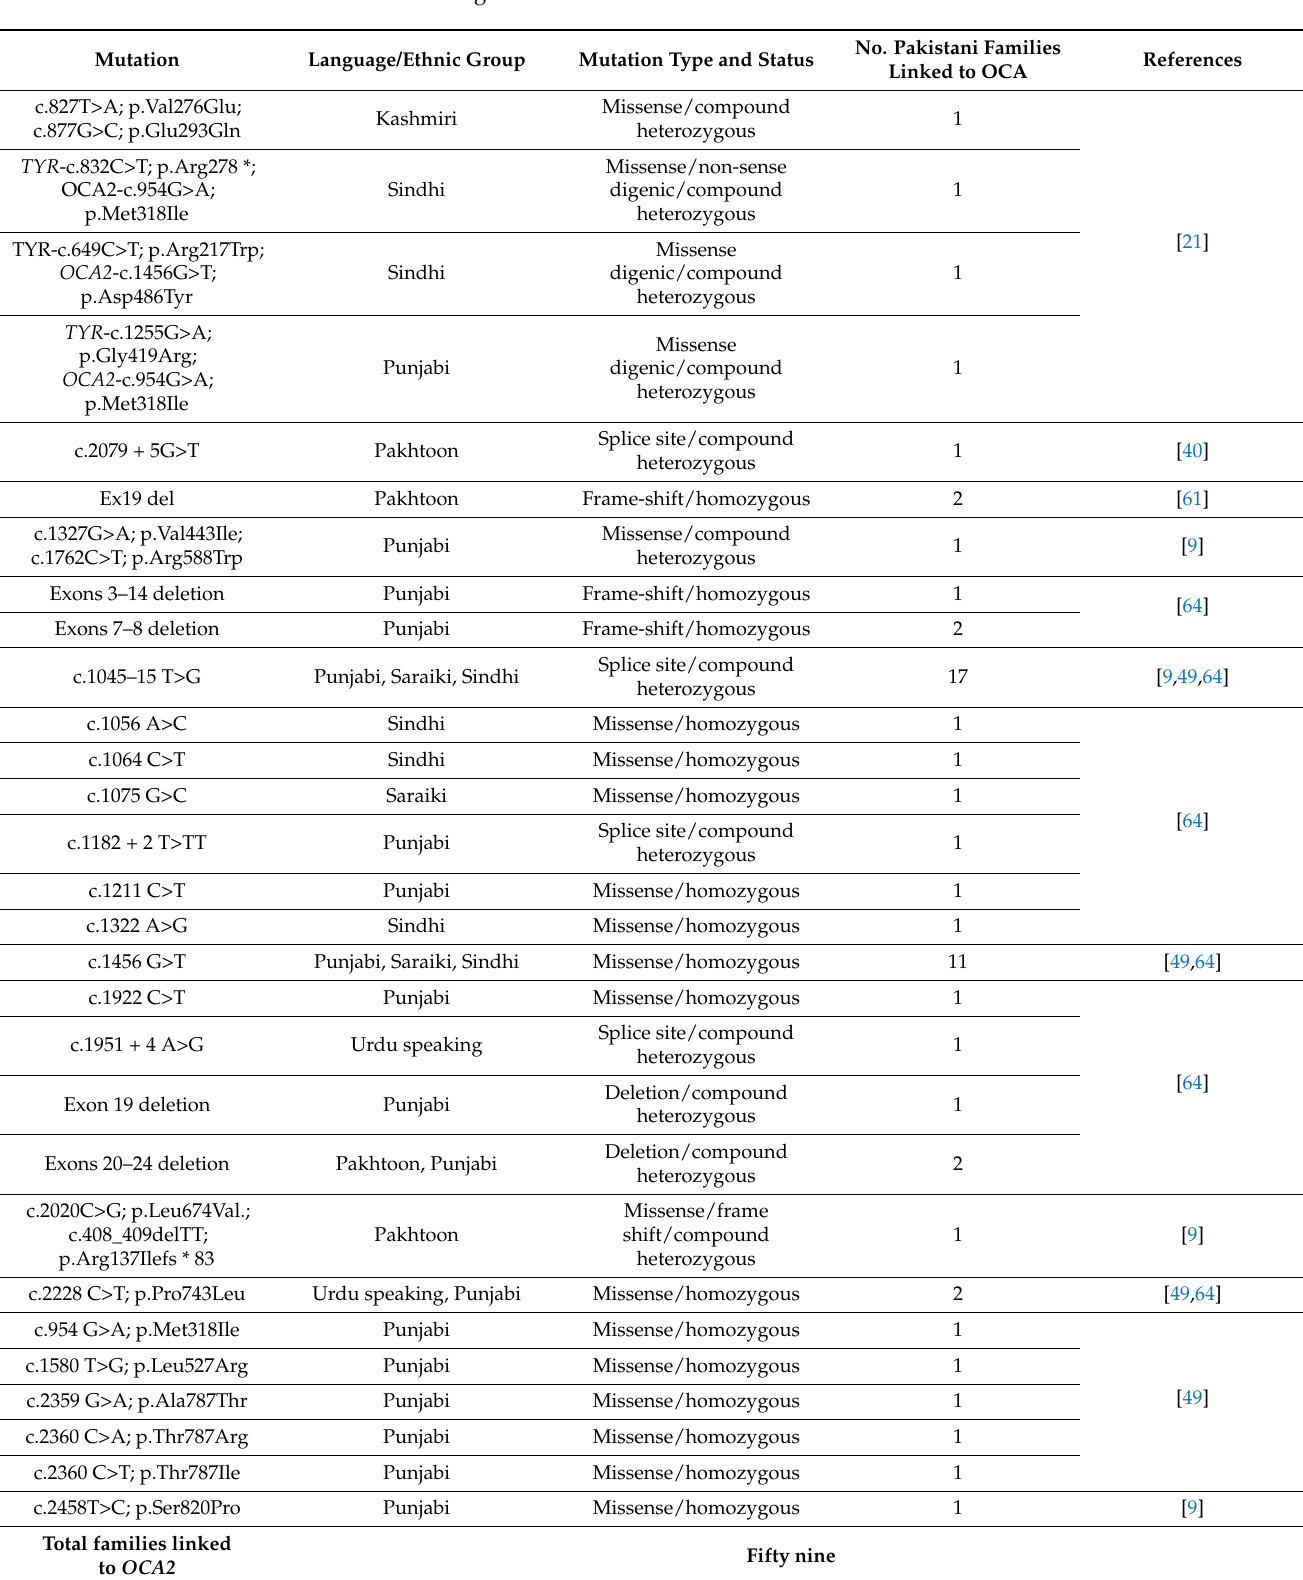
Table 3. OCA2 gene mutations in OCA families from